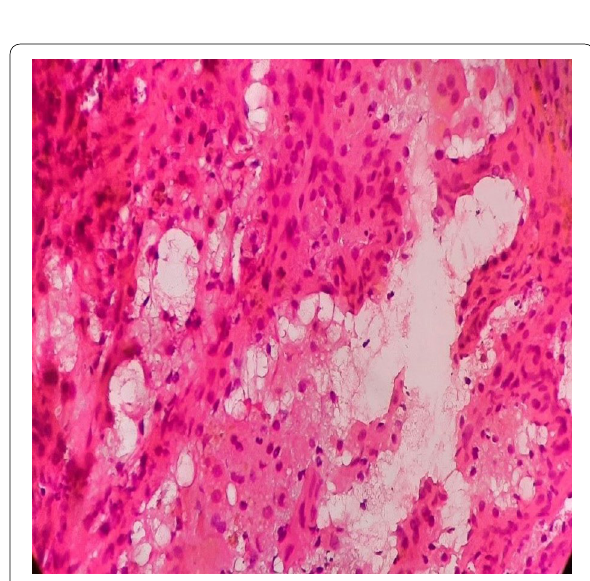
Fig. 2 Left lung biopsy specimen showing well-formed vasoformative channels suggesting cardiac angiosarcoma (Hematoxylin and eosin stain, 40 ×